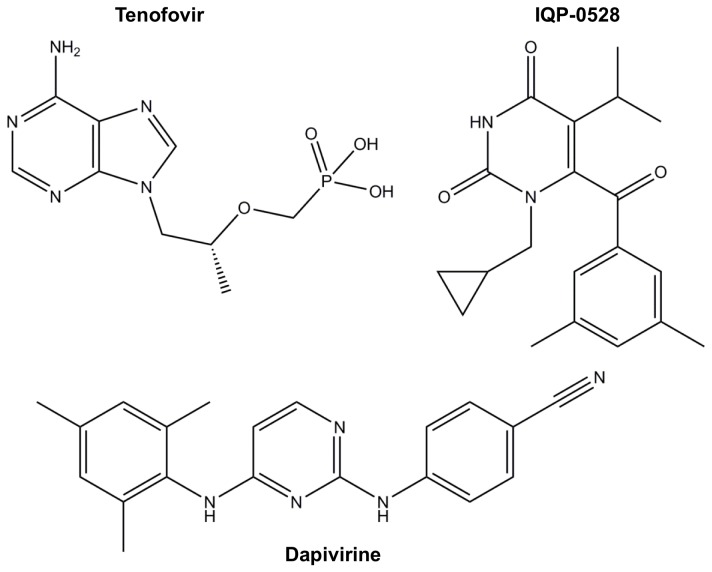
Chemical structures of Tenofovir, IQP-0528, and Dapivirine.